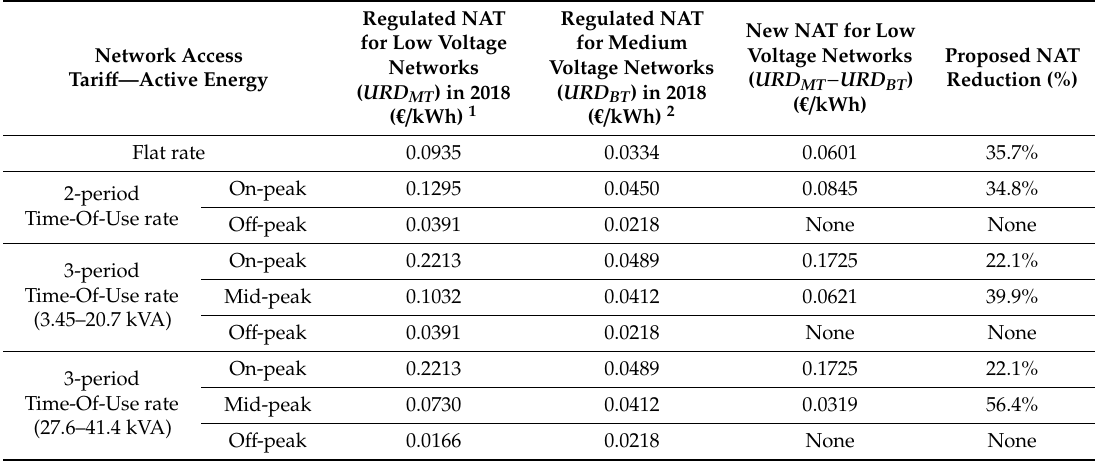
Table 1. Network Access tari ff reductions applicable for surplus distributed electricity traded within low voltage P2P energy sharing